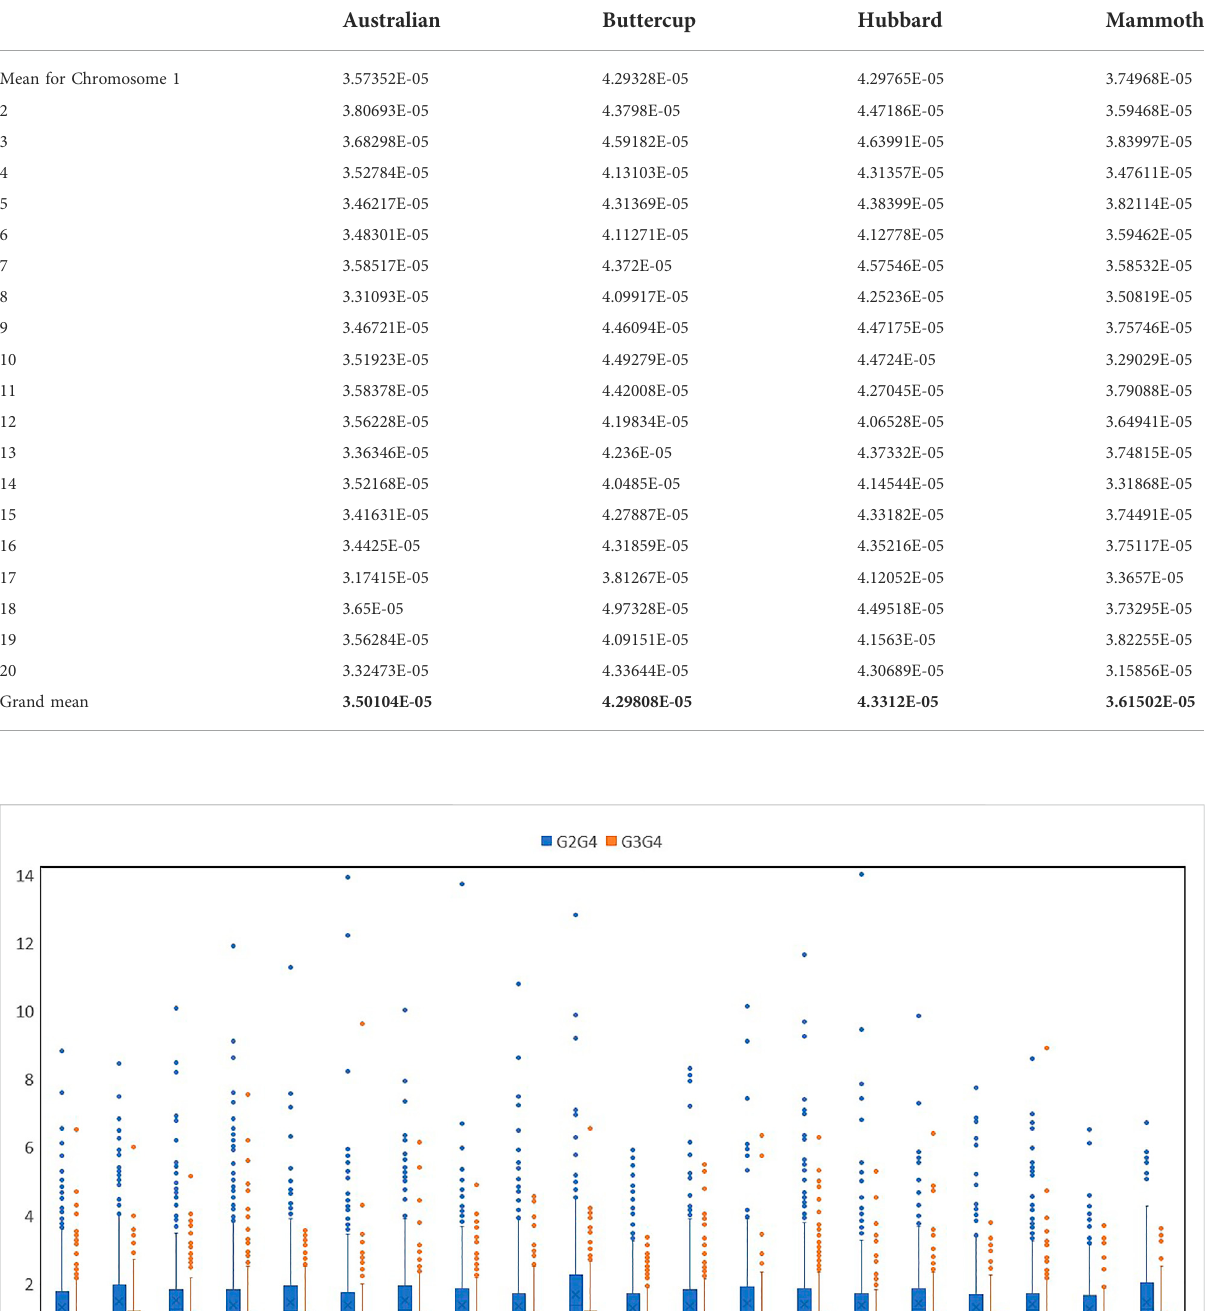
TABLE 1 Chromosome-wide distribution of nucleotide diversity ( π ) across Cucurbita maxima groups.